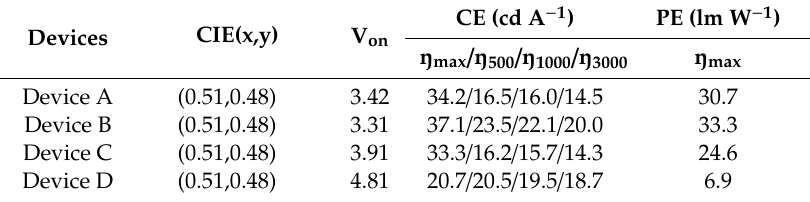
Table 1. Detailed performance of devices A–D. CIE(x,y): defined as CIE coordinate at 1000 cd m − 2 ; V on : defined as the drive voltage at 1 cd m − 2 ; ŋ max /ŋ 500 /ŋ 1000 /ŋ 3000 : maximum e ffi ciency, e ffi ciencies at 500, 1000 and 3000 cd m − 2